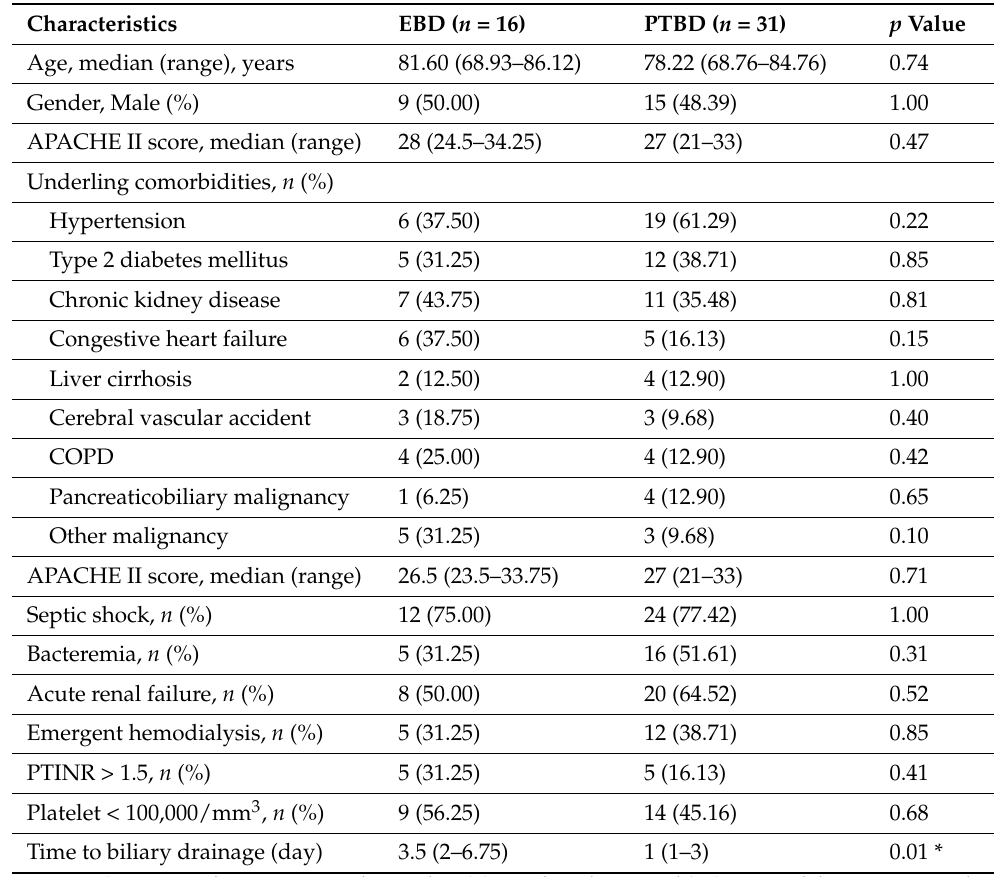
Table 1 . Baseline characteristics of study subjects .